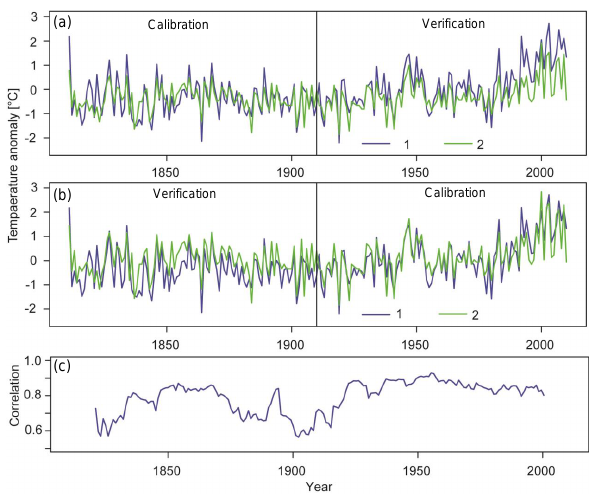
Figure 5. Comparison of measured (1) and reconstructed (2) mean Czech April–August temperatures: anomalies with respect to the 1961–1990 period. Linear regression method of reconstruction was performed for (a) early (1811–1910) and (b) late (1911–2010) cal- ibration periods; (c) running correlations (window 21 years) be- tween mean Czech April–August temperatures and grape-harvest dates during the 1811–2010